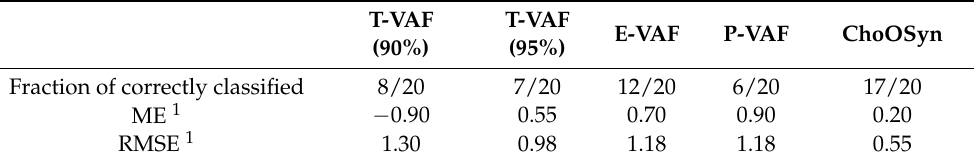
Table 2. Real dataset—Performance of the different methods as the fraction of correctly classified, mean error (ME), and root-mean-squared error